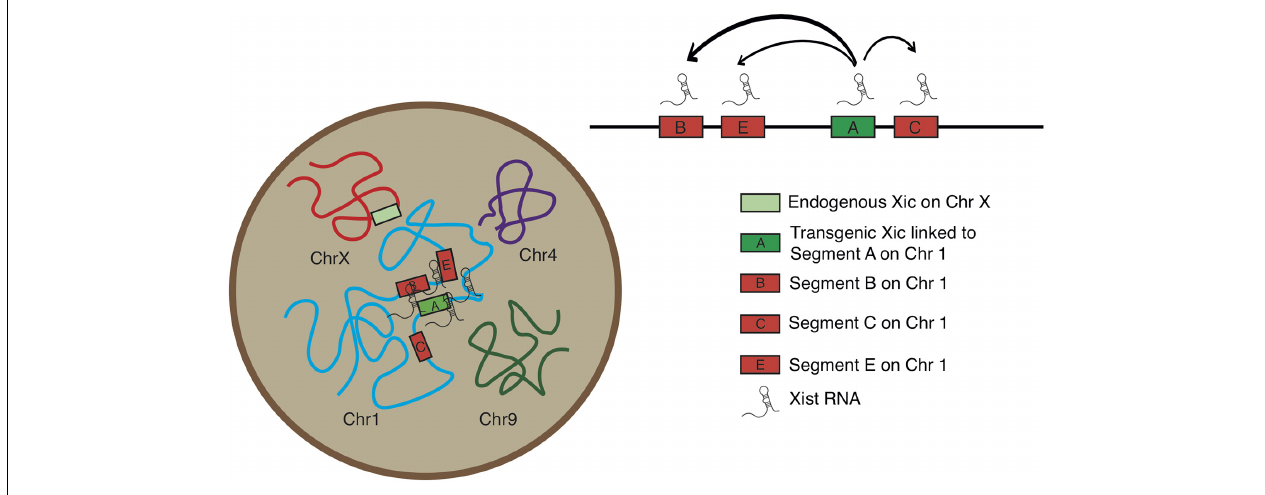
FIGURE 5 | Model for Xic transgene activating Xist RNA and silencing chromosome 1 segments facilitated by three-dimensional chromosomal